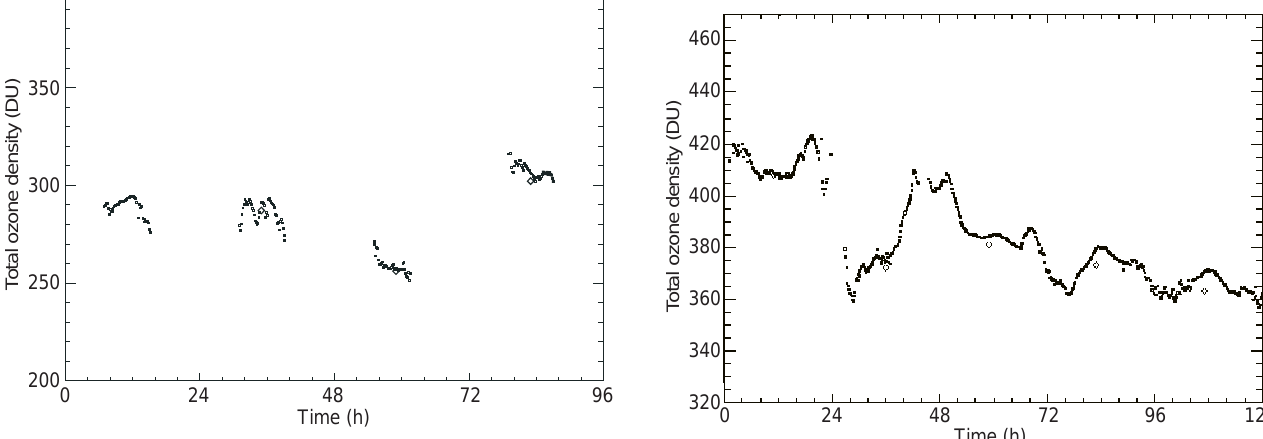
Fig. 2. Ground-based measurements at Oslo in the period October 1–4, 1996. Diamonds : Dobson measurements; dots : GUV measure- ments